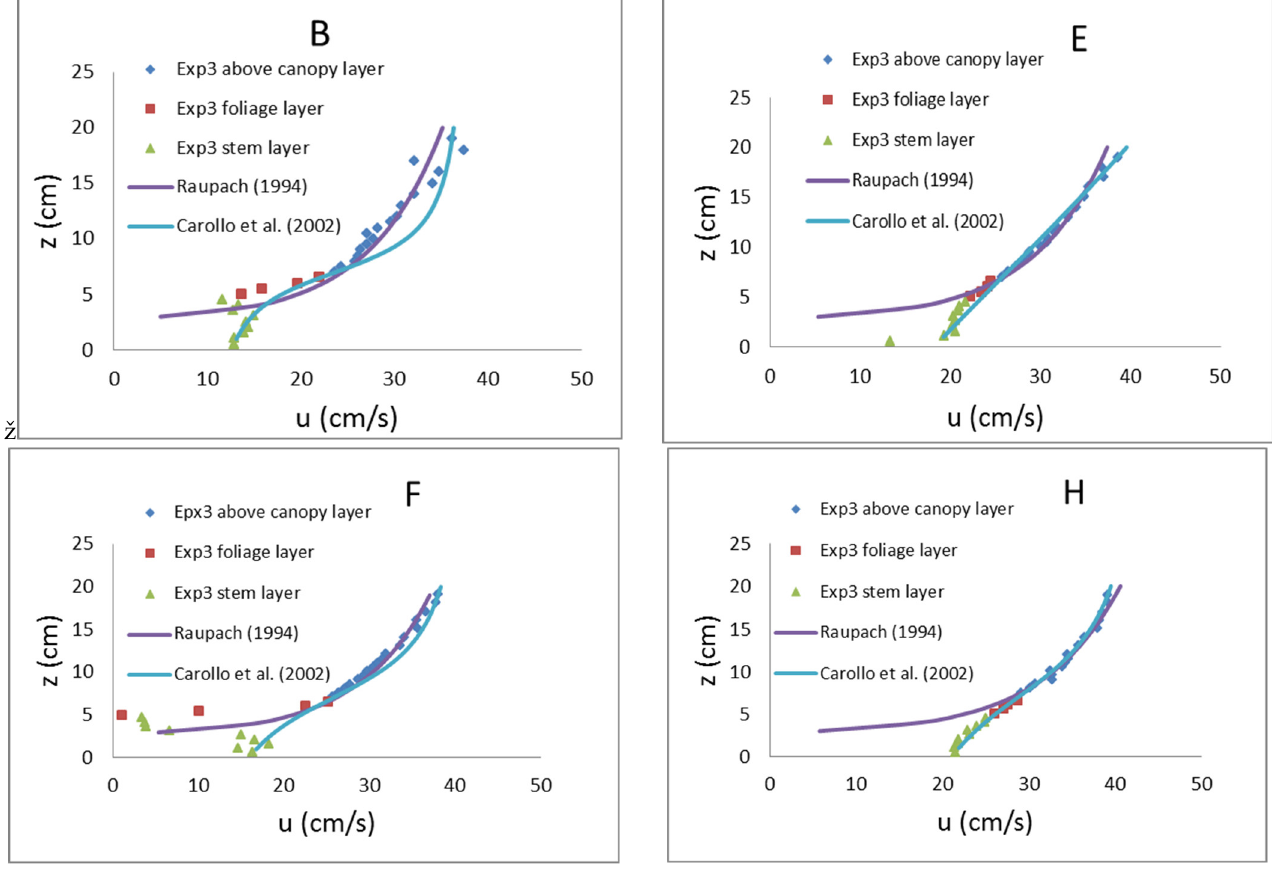
Figure 7. Velocity distribution data for Exp3, compared to equations of Raupach [19] and Carollo et al. [12]. The respective results at positions B and F for Exp1, Exp4 and Exp5 are presented